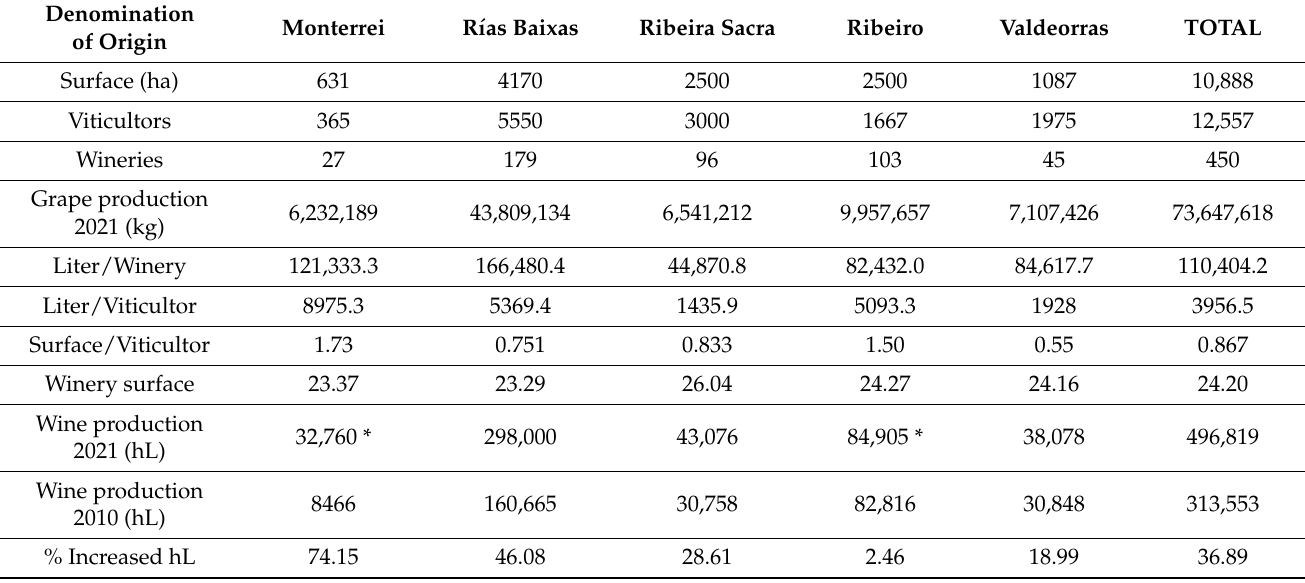
Data obtained from Spanish Ministry of Agriculture Fish and Foods (MAPA) [1], and from official web pages relative to the five DO: www.domonterrei.wine; https://doriasbaixas.com; https://ribeirasacra.org; www.ribeiro. wine; https://miconsejo.dovaldeorras.com/. (accessed on 17 October 2021) *: data from year